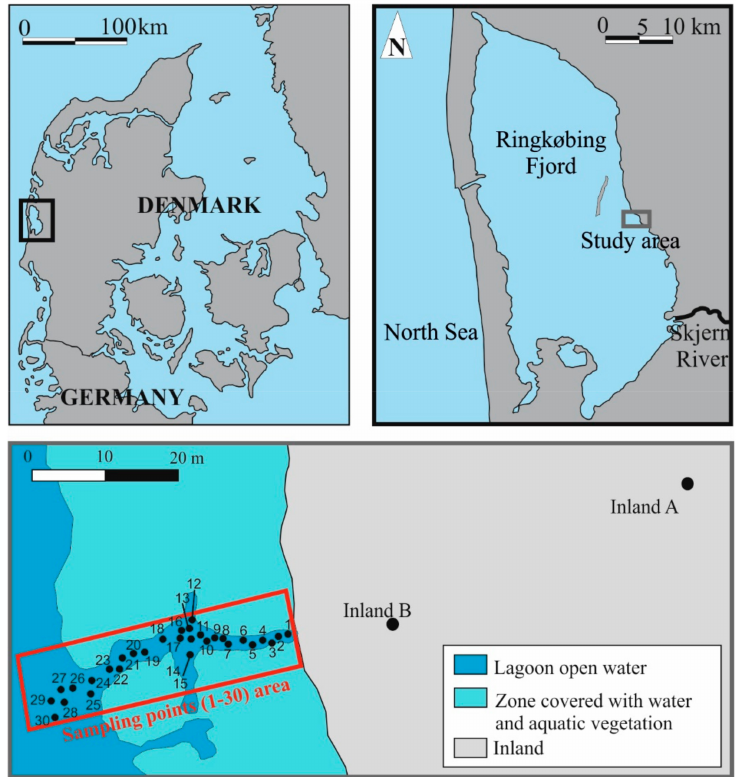
Figure 1. Study area location in Denmark and in Ringkøbing Fjord. Sampling points (1–30), inland wells, and general characteristics of the study